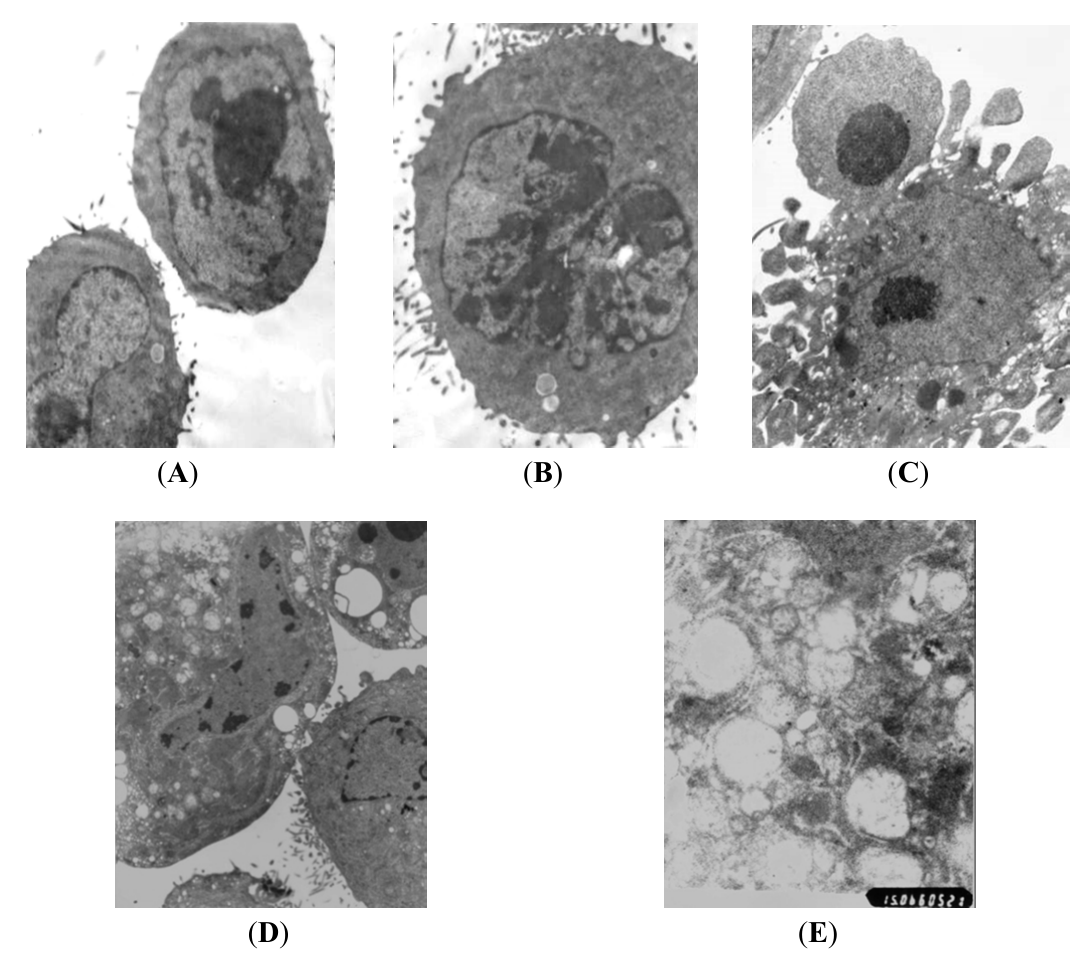
agglutination (5000×); ( C ) formation of apoptotic body (5000×); ( D ) characteristic ultrastructural morphology of autophagy in PC-2 cells (6000×); ( E ) autophagic vacuoles